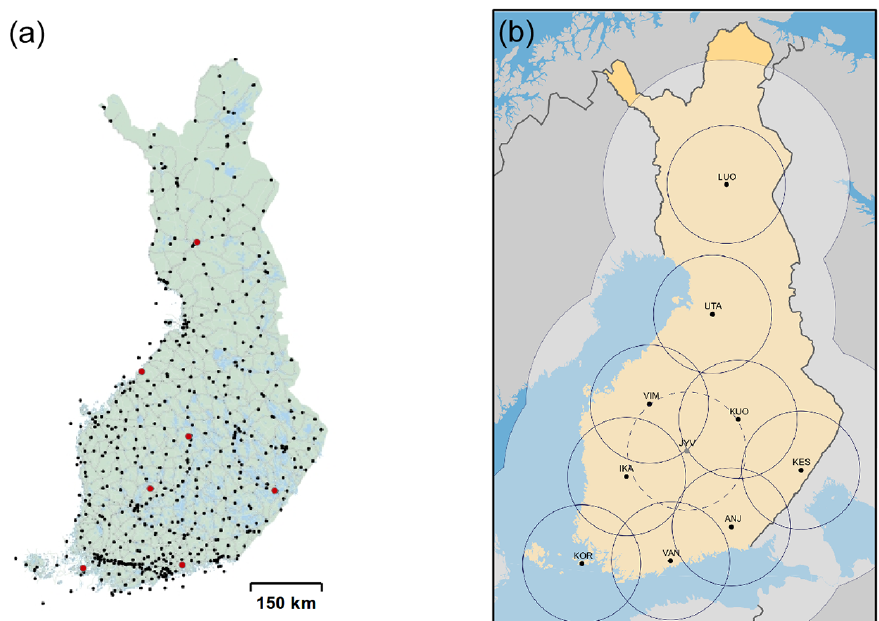
Figure 1. In panel (a) , the Finnish surface gauge stations are shown (as dots on the map); these are used to measure the hourly precipitation accumulation. The red dots indicate the position of the seven independent stations used for the verification. In panel (b) , the outer rectangular frame of the map depicts the LAPS analysis domain. The black dots represent the 10 Finnish radar stations and the outer black curved lines display their coverage. The thin circles surrounding each radar represent the areas where measurements are performed below 2km height. The dashed circle indicates radar station JYV, which was not included in the radar network during summer 2015.